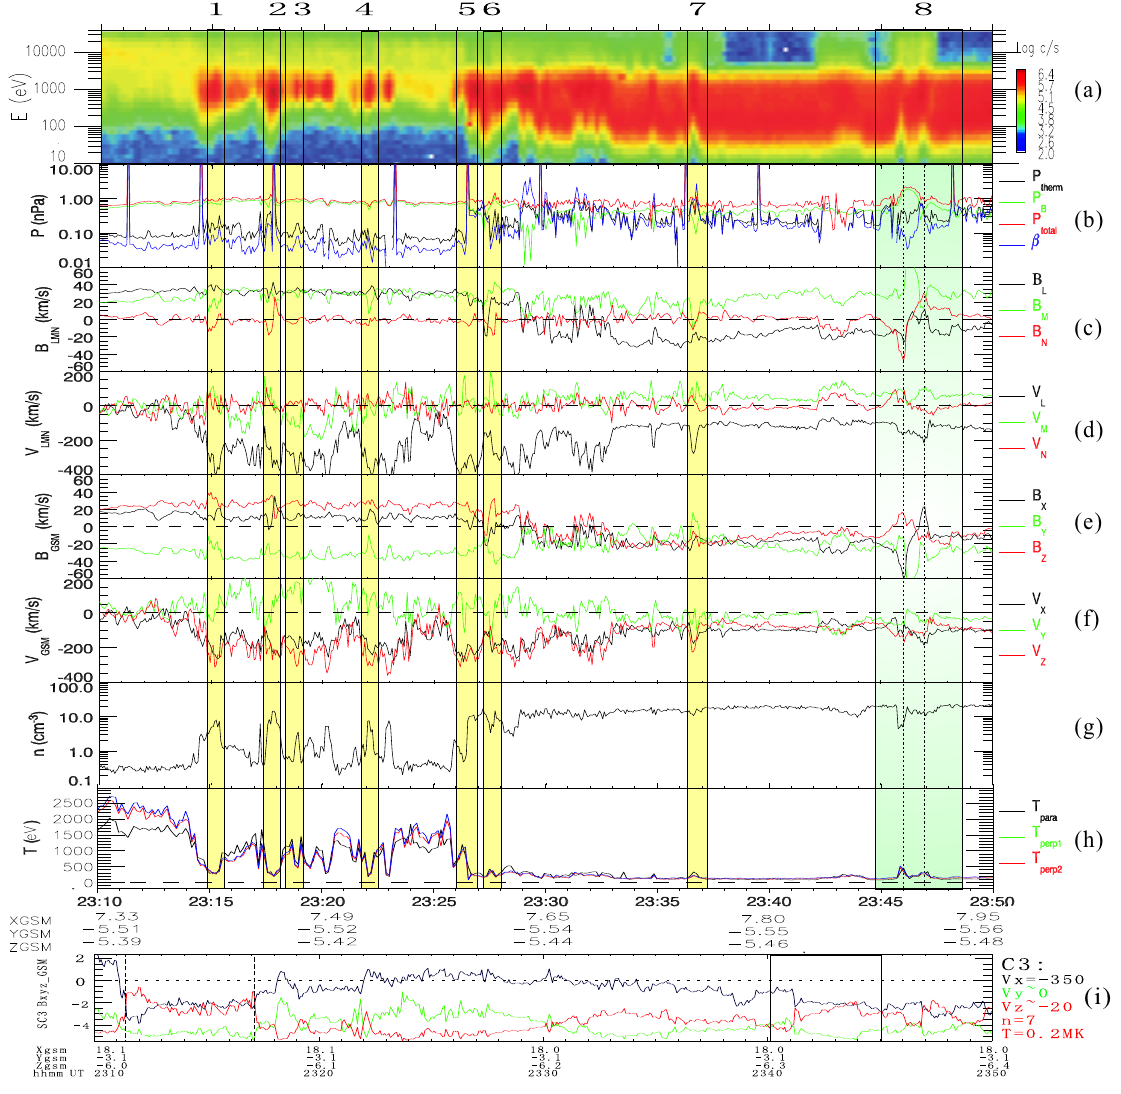
Fig. 2. Overview of the TC-1 and Cluster measurements on 18 March 2004. The bottom panel shows magnetic field measurements from Cluster and the rest of the panels are from TC-1: (a) spectrum of ions flux, (b)plasma pressure and magnetic pressure, (c)-(d) magnetic field and plasma velocity in the LMN coordinates, (e)-(h) magnetic field, plasma velocity, density and temperature in the GSM coordinate system. The yellow masks show the flux ropes and the blue mask shows the FTE. Table 1. The axis orientation and V HT of the flux ropes in the GSM coordinates.